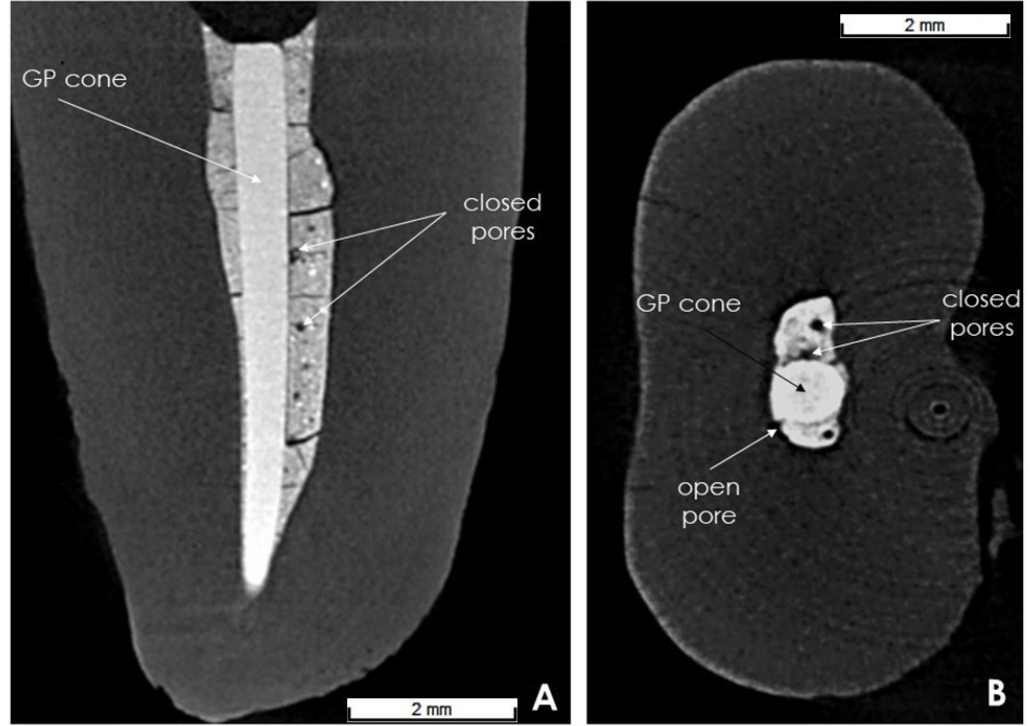
Figure 3. Representative transverse ( A ) and sagittal ( B ) cross sections illustrating the closed and open pores. open